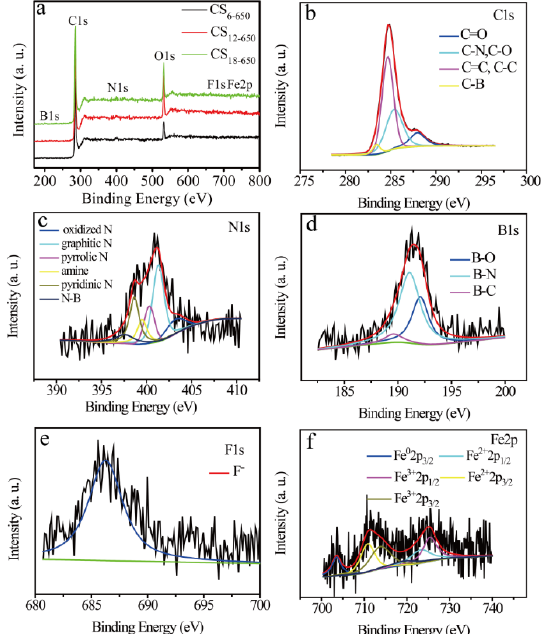
Figure 4. X-ray photoelectron spectroscopy (XPS) survey spectra of CS 6-650 , CS 12-650 and CS 18-650 ( a ). High-resolution XPS spectra of ( b ) C 1s, ( c ) N 1s, ( d ) B 1s and ( e ) F 1s, ( f ) Fe 2p for the CS 12-650 .